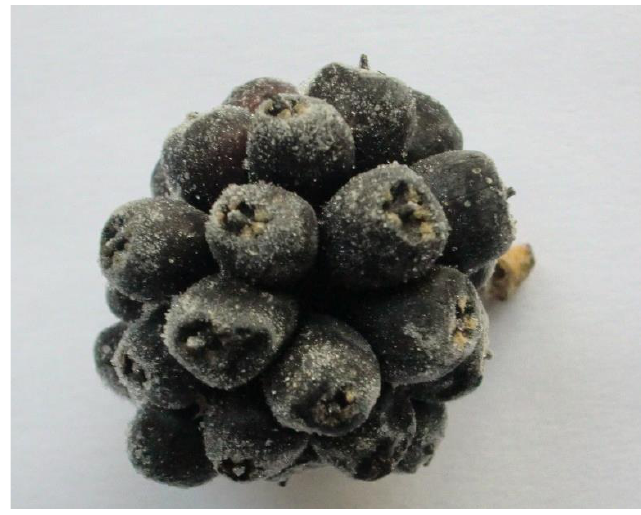
Figure 1. Fruits from Acanthopanax sessiliflorus (Rupr. & Maxim.) Seem.